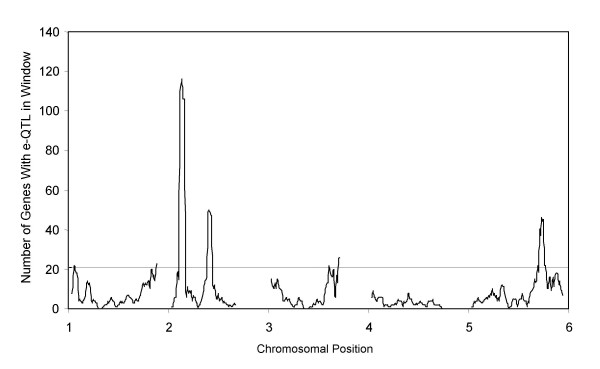
Broad effect eQTL regions detected via the summation approach. The number of genes showing eQTLs within a 5 cM sliding window is shown. The P = 0.05 cutoff for significant enhancement (horizontal line) is equal to 27 genes with an eQTL within a 5 cM sliding window. A total of 245 genes were used for mapping eQTLs. The five chromosomes lie along the x axis and begin at the corresponding number such that 1 is the start of chromosome I, etc. All five chromosomes are < 100 cM in this sample of 148 RILs of the Bay-0 × Sha population.